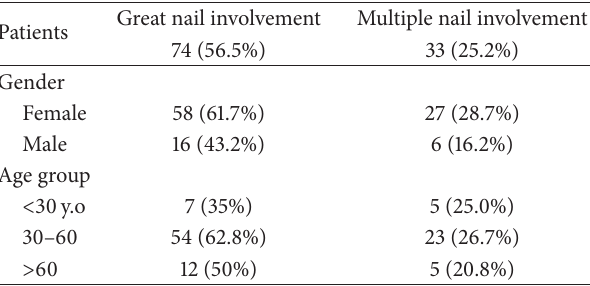
Table 4: Evaluation of patients to multiple nail